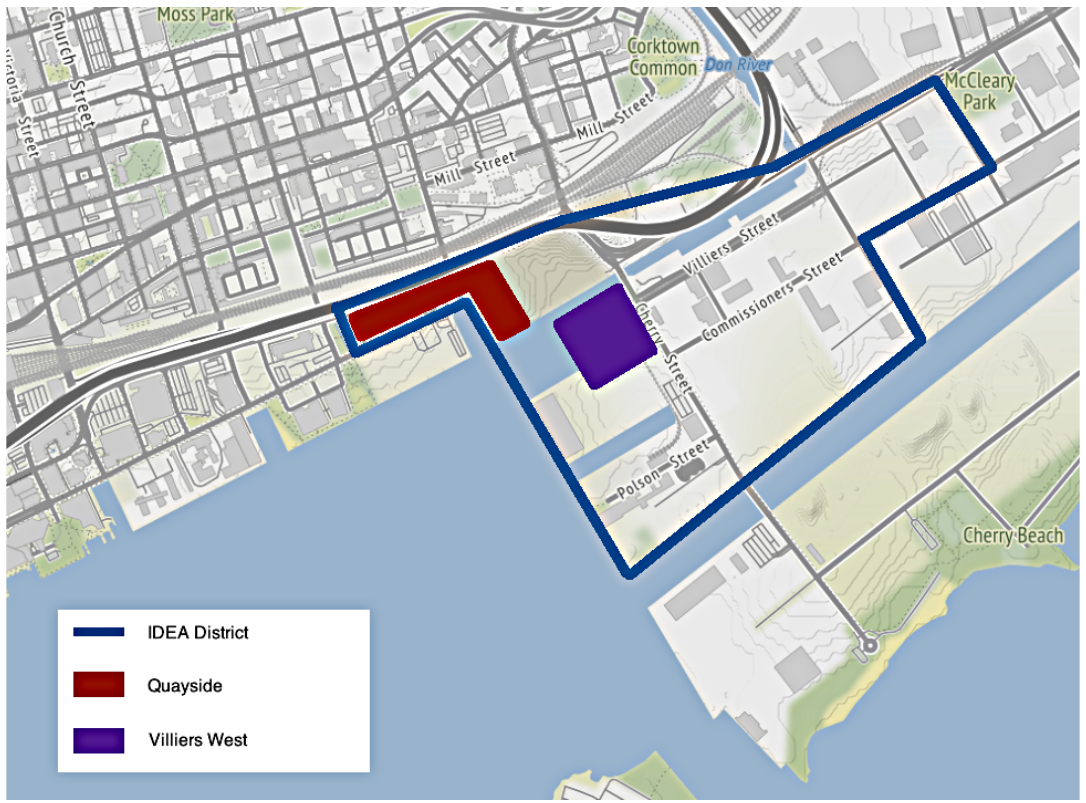
Figure 1. Proposed SL IDEA district representing current site conditions. Proposed flood protection measures are not rep- resented. Source: OpenStreetMap (openstreetmap.org) contributors under the Open Database Licence—CC